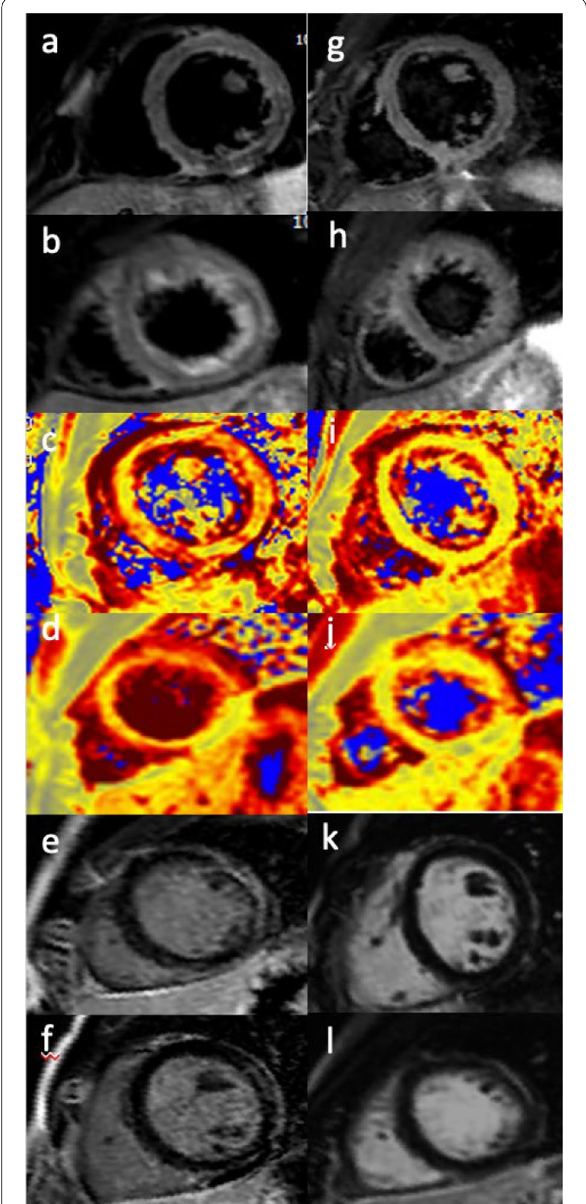
Fig. 2 A 25-years-old-man with symptoms of fever, fatigue, shortness of breath and chest pain which developed one day following the second dose of COVID-19 vaccine. T2-short tau inversion recovery CMR short axis ( a , b ) demonstrating edema in the antero-lateral segments. T2 mapping short-axis view confirmed the presence of edema in the same segments ( c , d ). Late gadolinium enhancement short-axis view showed a subepicardial antero-lateral scar with an associated pericardial enhacement ( e – f ). Follow-up CMR was done 3 months from start of symptoms revealing the disappearance of edema in both the T2-short tau inversion recovery CMR short axis ( g , h ) and T2 mapping short-axis view ( i , j ). There is no evidence of focal areas of late gadolinium enhancement in the antero-lateral segments ( k , l